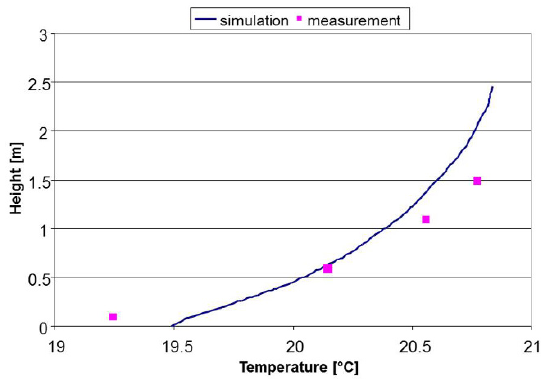
Figure 13. Absolute humidity [kg/kg].